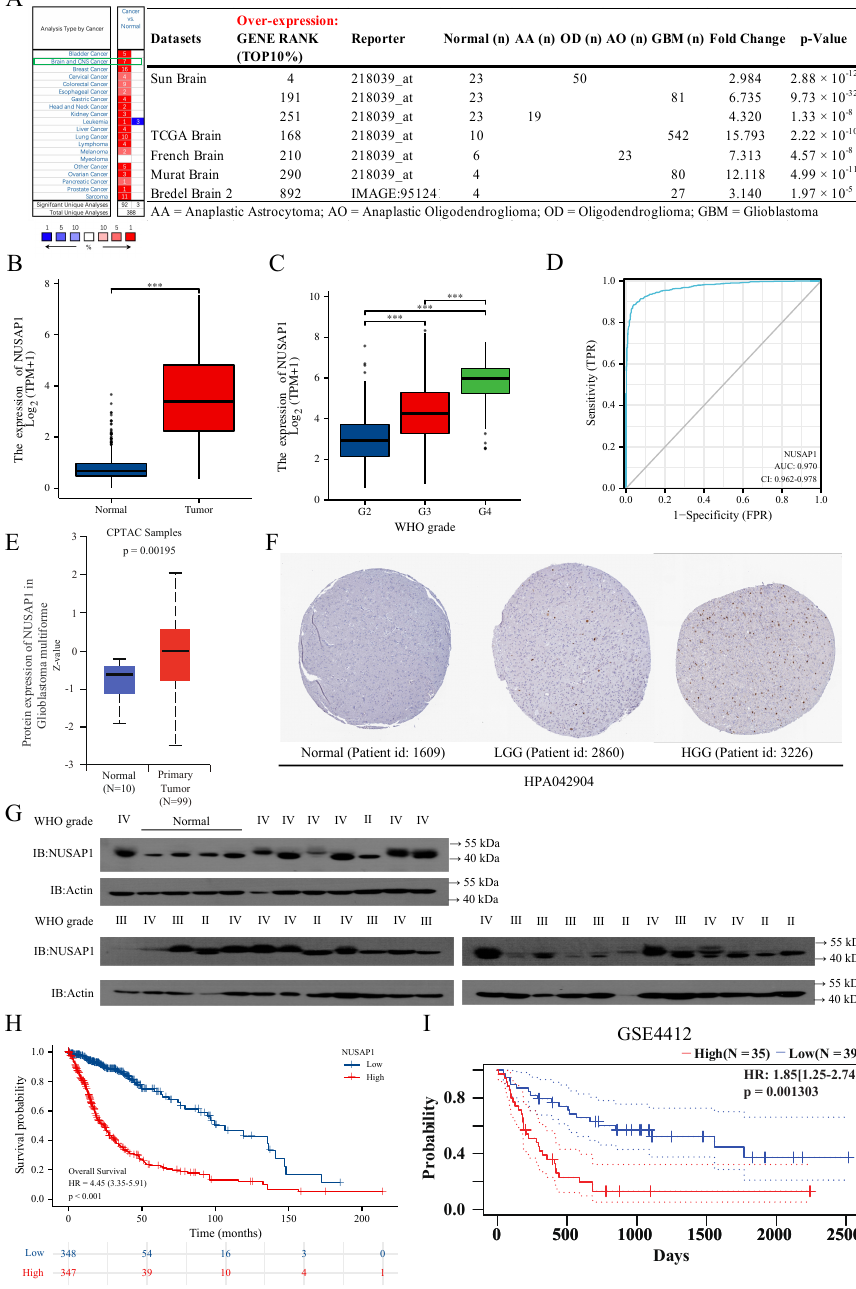
Figure 1. High expression of NUSAP1 correlates with higher tumor grade and poor prognosis of glioma. ( A ) The transcription levels of NUSAP1 in 20 different types of cancers and 7 datasets of glioma of Oncomine. ( B ) Comparison of NUSAP1 expression in GBM and normal tissues from TCGA+GTEx database. ( C ) Expression of NUSAP1 in different grade gliomas from TCGA database. ( D ) ROC curve is applied to evaluate the diagnostic value of NUSAP1 for glioma. ( E ) Comparison of NUSAP1 protein level in GBM and normal tissues of CPTAC datasets with the online tool of UALCAN. ( F ) Protein levels of NUSAP1 in normal tissues, LGG and HGG from the HPA database. ( G ) Western blot analysis of NUSAP1 protein lysates from glioma tissues and normal brain tissues. ( H ) Kaplan-Meier survival analysis of overall survival duration in TCGA glioma patients according to NUSAP1 expression. ( I ) The relationship between NUSAP1 expression and prognosis of glioma in PrognoScan is validated by GSE4412. *** p <